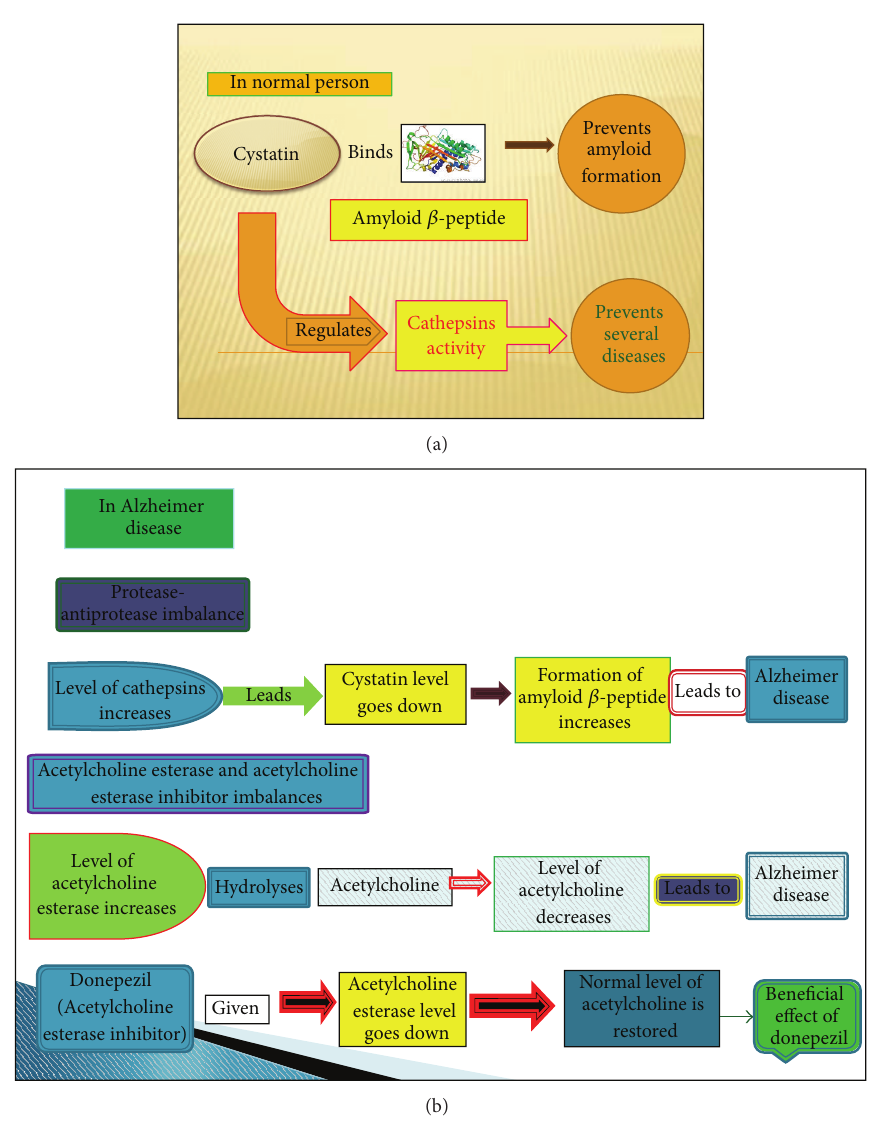
Figure 2: Proposed